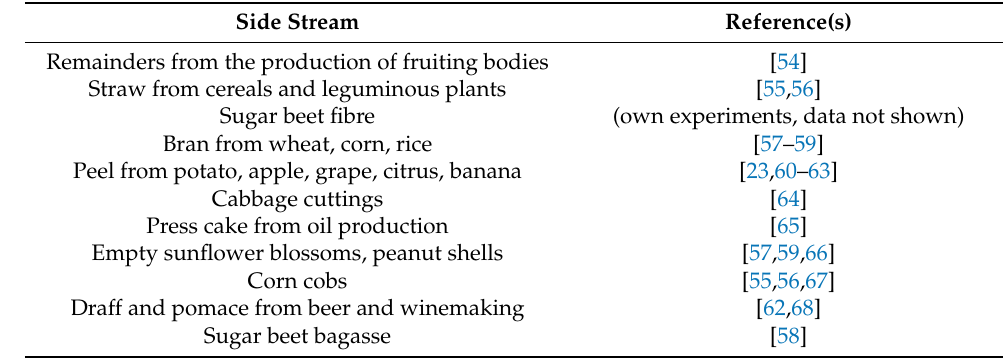
Table 1. Agro-industrial side-streams added successfully to submerged grown mycelia of Basidiomycota. Side Stream